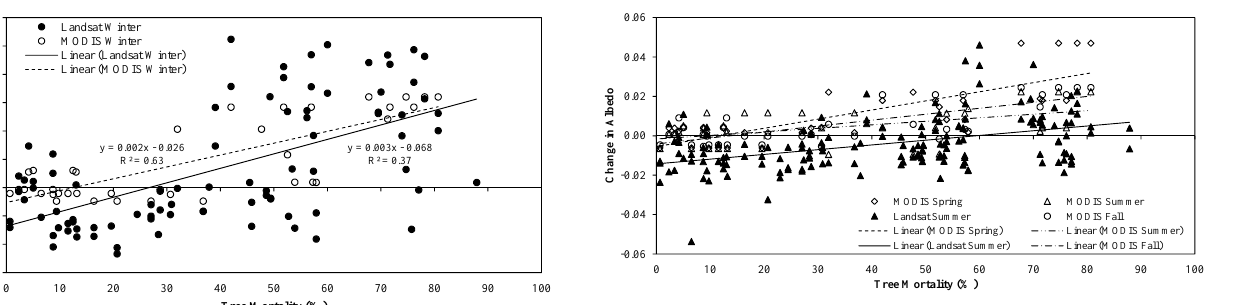
Fig. 3. Change in winter albedo with MPB outbreak severity, de- fined as percent tree mortality, for outbreaks 4–13yr in age (gray attack stage).